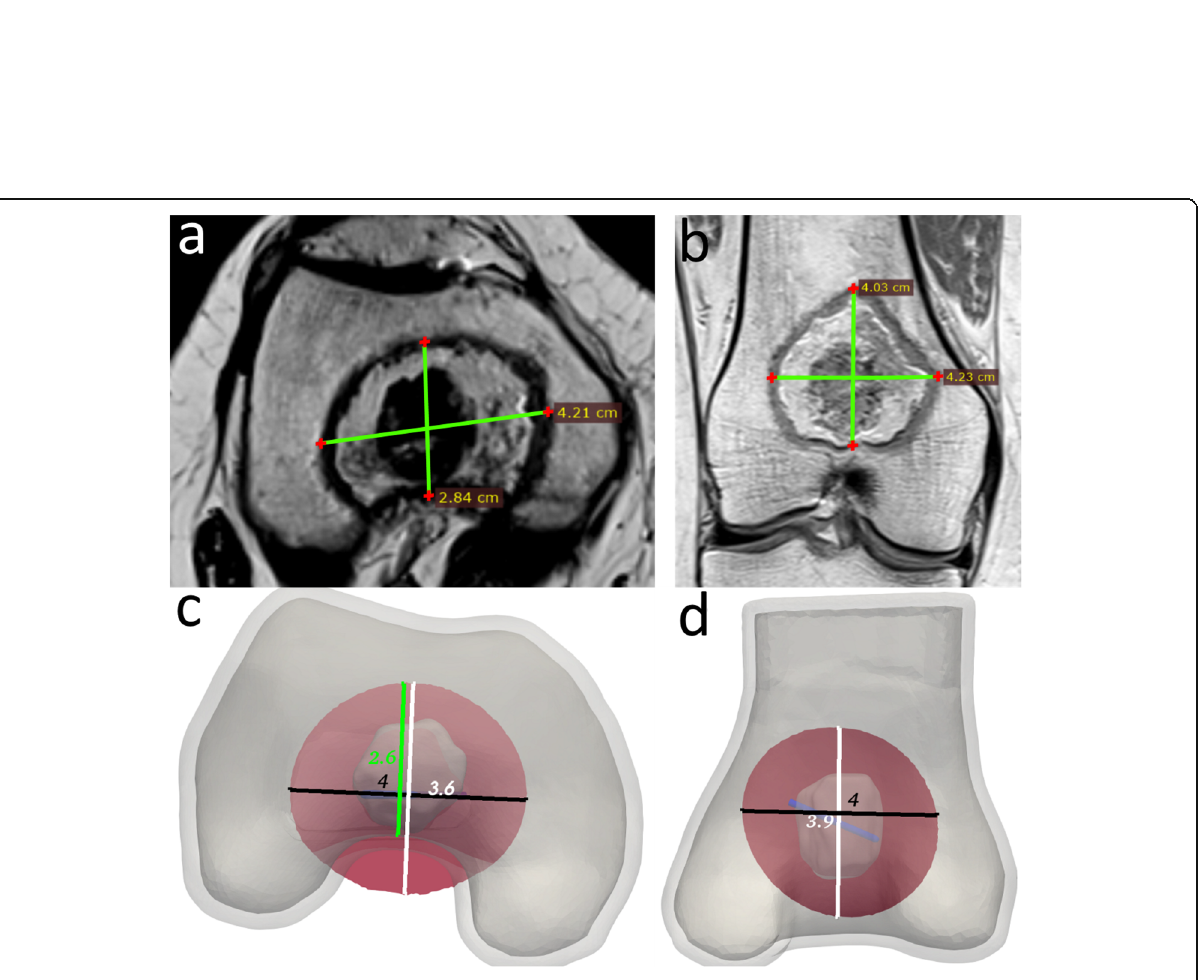
Fig. 4 a , b Resulting ablation diameters on the magnetic resonance imaging (MRI) study performed 3 months after the radiofrequency ablation (the same case of Figs. 2 and 3). c , d Resulting ablation diameters from the simulations. The ablation zones are represented as a transversal cut at the height of the electrode, inside the three-dimensional geometry, to match the direction of the MRI measurements. c The green line is the measurement of the ablation diameter as if it were to be taken until the cortical bone and is shown here as an example of the main difference between the results from the simulations and the radiological